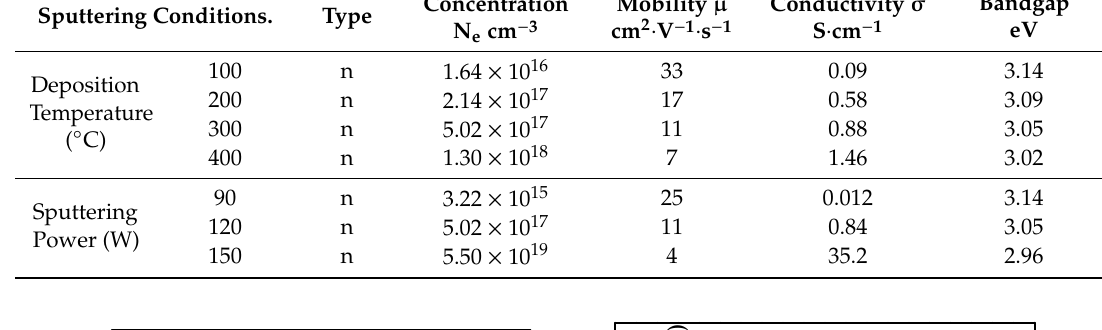
Table 4. Electrical properties of Ge 0.07 GaN films deposited at different temperatures. Sputtering Conditions.